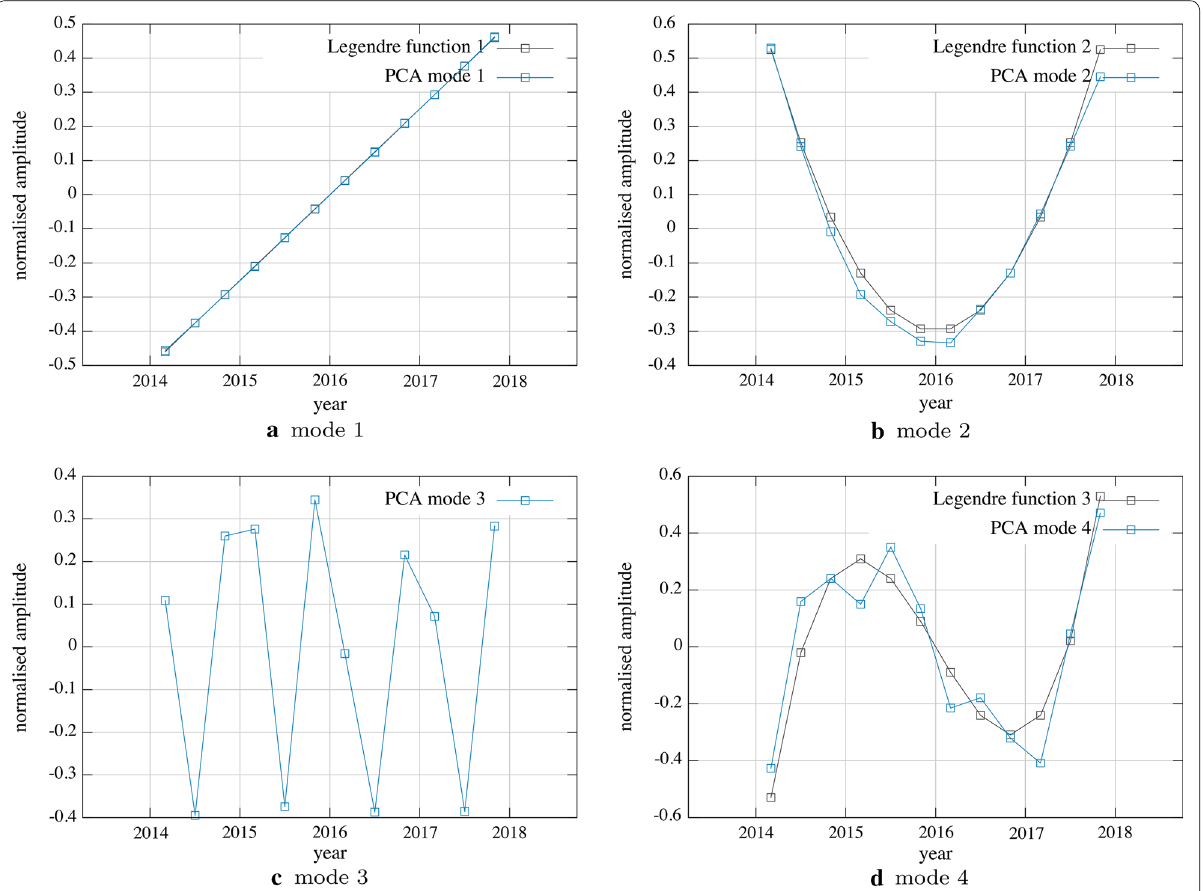
Fig. 2 As in Fig. 1 but from